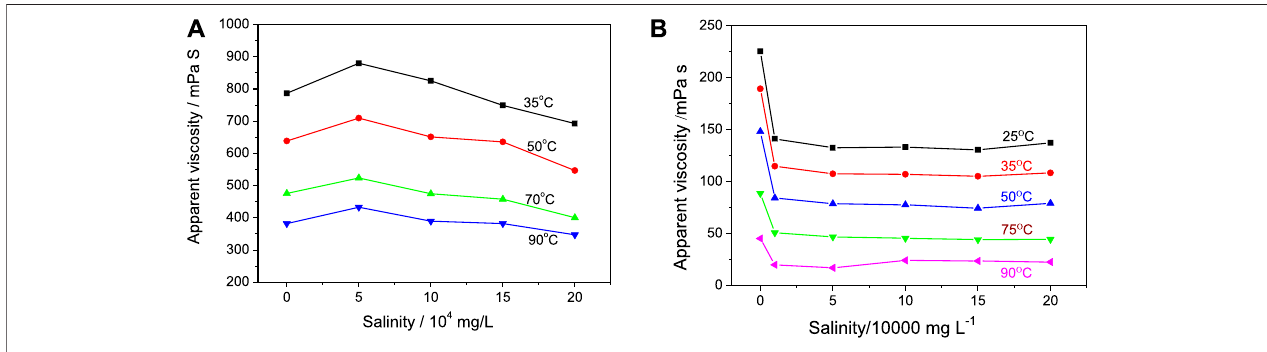
FIGURE 4 | Solution viscosity change of p-HPAM (n AM /n AA / PEGMA (cid:2) 9/1/0.14) (A) and (n AM /n AA / PEGMA (cid:2) 9/1/0.12) (B) to salinity at different temperature.